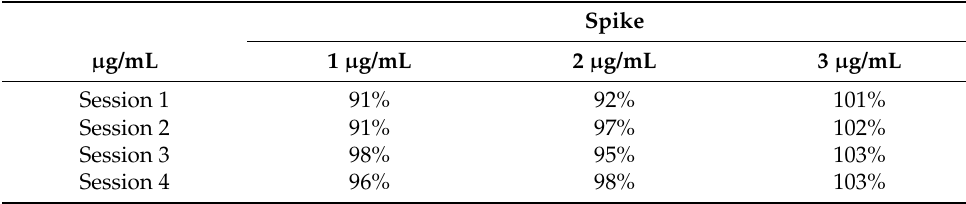
Table A4. HPAEC-PAD recovery values per sessions.